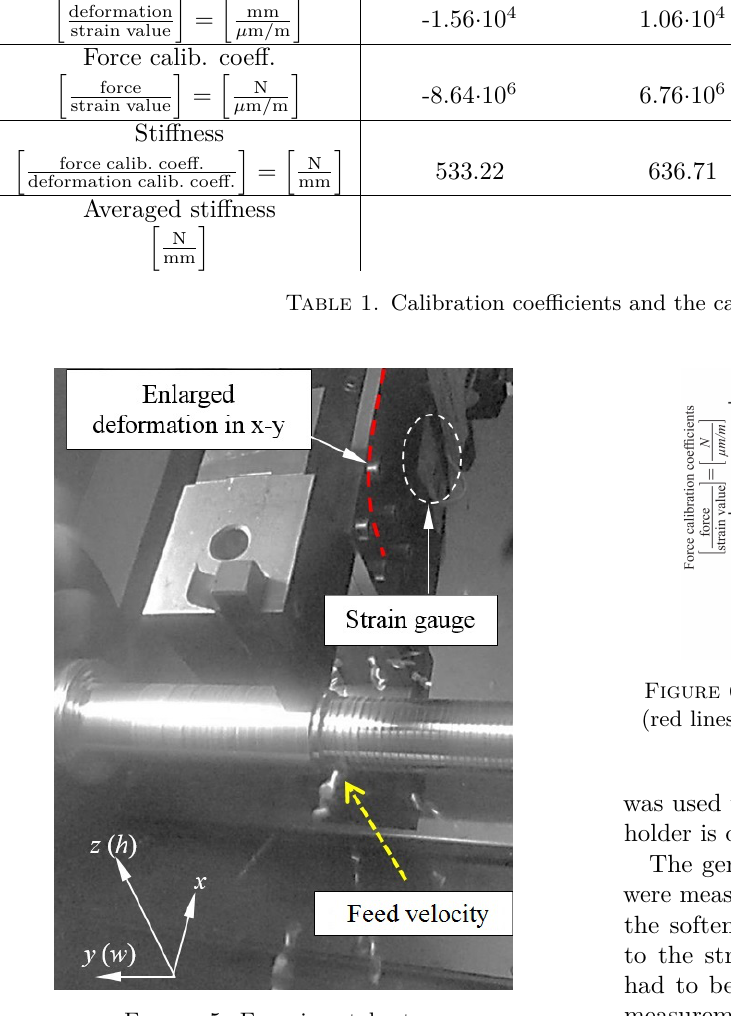
Figure 5. Experimental setup.